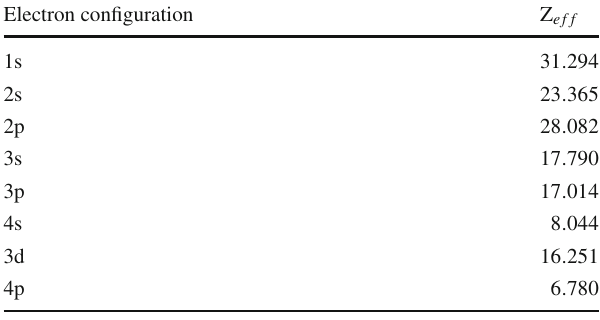
Table 1 Effective nuclear charges for Ge electron configuration Electron configuration